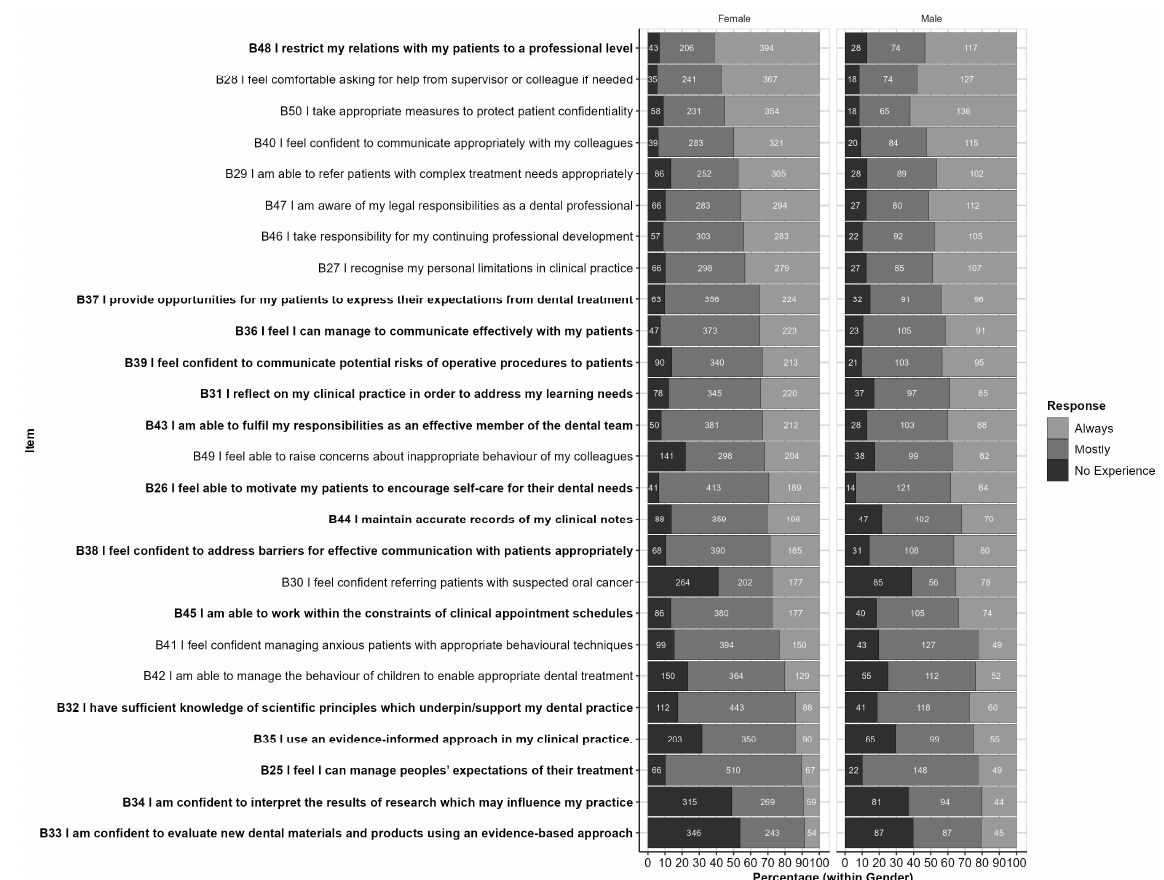
Figure 4. Responses by Part B items (within Gender): Responses are ordered from highest to lowest proportion of ‘Always’ responses (across Genders). Items for which response profiles differ by gender ( p < 0.05) are highlighted in bold text. Table 4. Association between Gender and Item Responses for Part B: Specific p -values from Chi- Squared tests of association for items showing a statistically significant association between Gen- der and Item Responses for Part B.